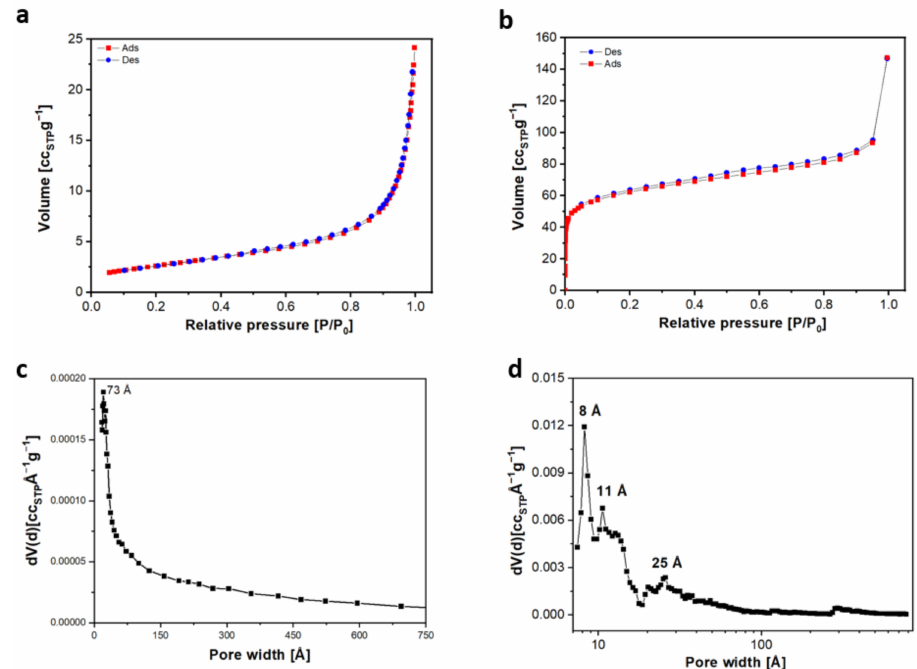
Figure 5. N 2 adsorption–desorption isotherms at 77 K of kaolinite ( a ) and silica particles ( b ), and pore size distribution (BJH method, adsorption branch for kaolinite and NLDFT method, cylinder pore, adsorption branch model for silica particles) of kaolinite ( c ) and silica particles ( d